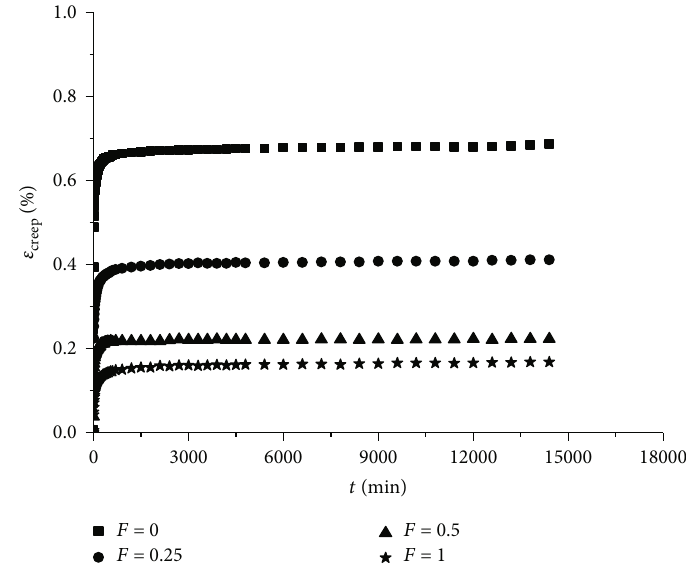
Figure 5: Time-varying curve of the creep strain of unsaturated soil samples under di ff erent stress